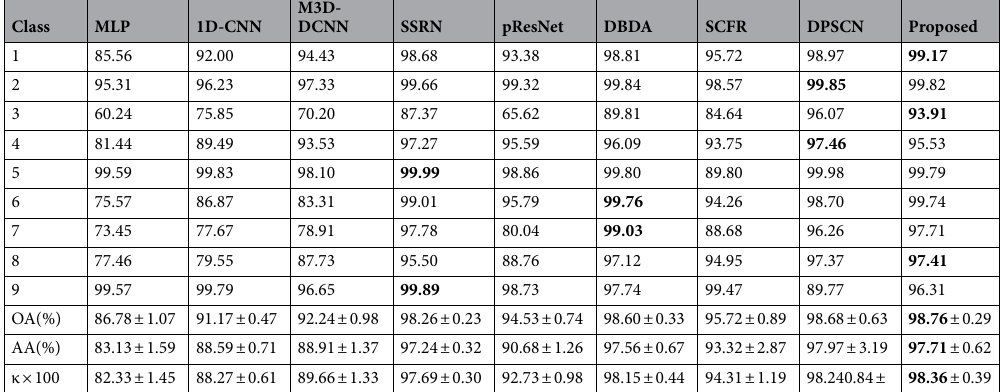
Table 7. Classification results of 1% samples of PU dataset. Significant values are in bold.